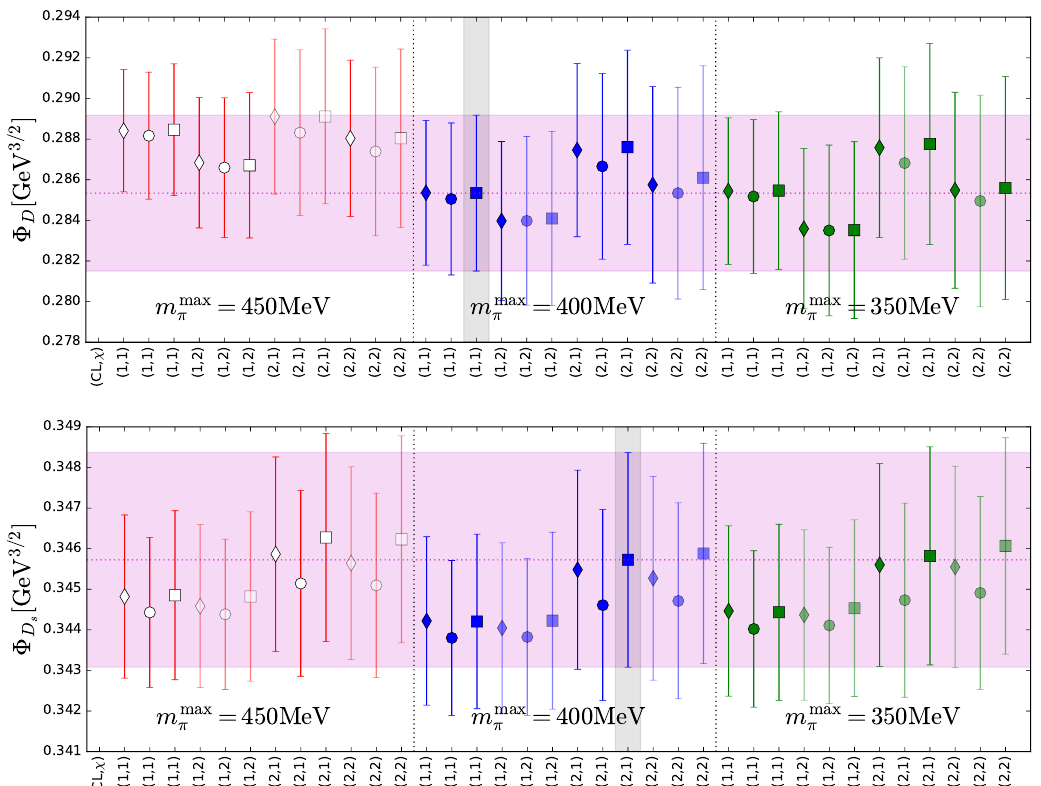
Figure 12 . Comparison of the results of the di(cid:11)erent choices in the global (cid:12)t for (cid:8) D (top) and (cid:8) D (bottom). The grey and magenta bands highlight the (cid:12)t shown in (cid:12)gure 11. The di(cid:11)erent s symbols indicate di(cid:11)erent ways of (cid:12)xing the heavy quark mass, i.e. H = D ( connected part of) (cid:17) c ( (cid:3) ). Fainter data points indicate that at least one of the heavy mass dependent coe(cid:14)cients is compatible with zero at the one sigma level. More detail about the data shown here is given in the